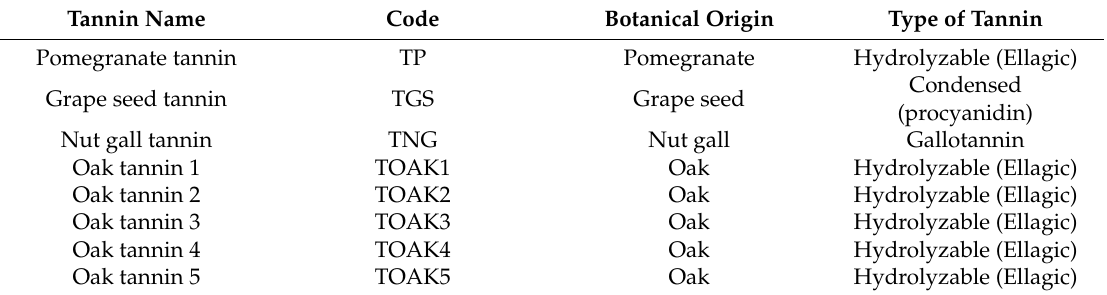
Table 1. List of the analyzed tannins. For each tannin, the given code, the botanical origin, and the type of tannin are also reported.